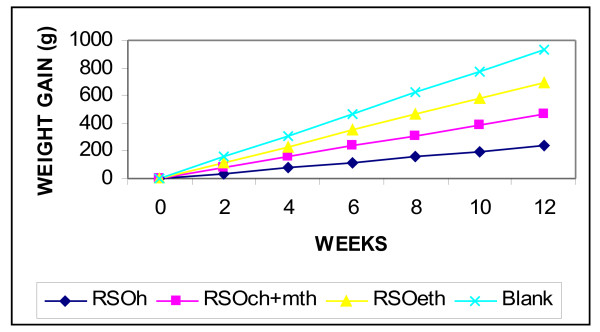
Body weight gain of rats feed RSO and blank control. Note: RSOh: RSO was extracted using hexane as solvent, RSOch+mth: RSO was extracted using mixture of chloroform and methanol as solvent, RSOeth: RSO was extracted using ethanol as solvent, Blank: rats food.